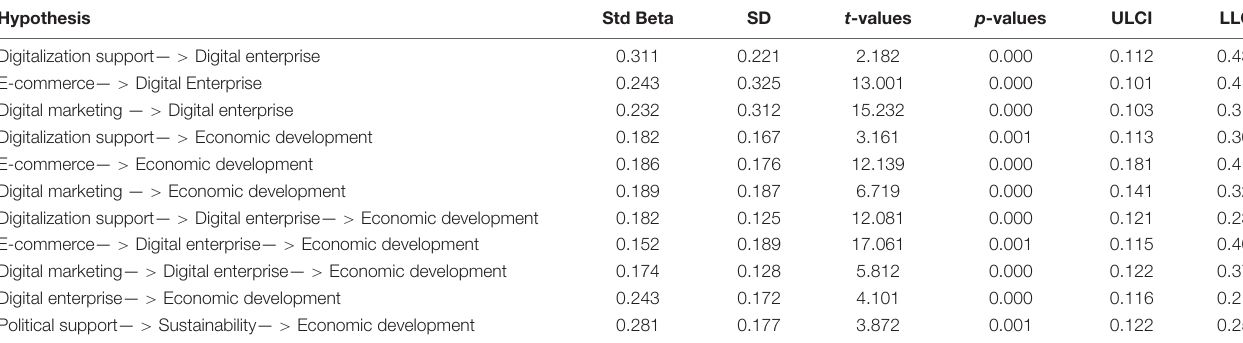
FIGURE 2 | Structural model results. TABLE 4 | Hypothesis